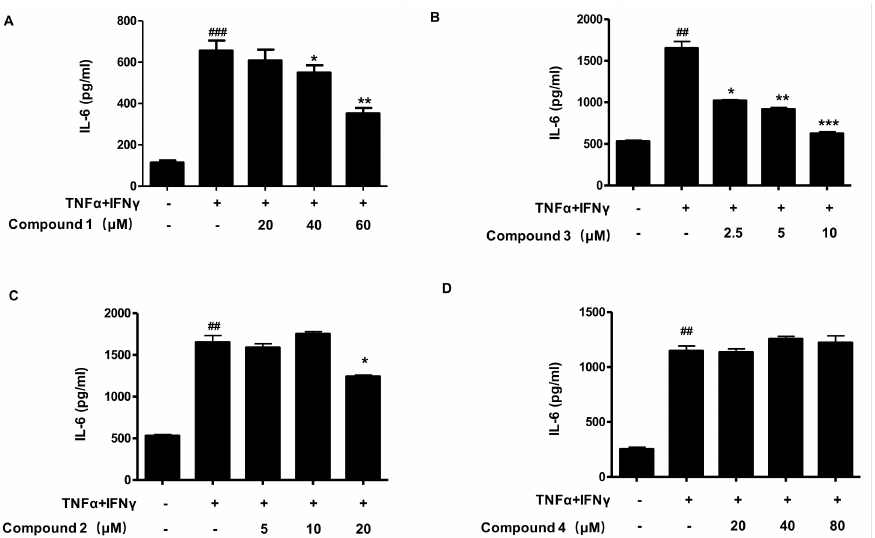
Figure 3. Effects of compounds 1 , 2 , 3 , and 4 on the secretion of IL-6 in TNF- α /IFN- γ -stimulated HaCaT cells ( A – D ). The secretion of IL-6 was measured by using the culture supernatant of TNF- α /IFN- γ -stimulated HaCaT cells. The cells were pretreated with the indicated concentrations of compound 1 , 2 , 3 , and 4 for 3 h (+) or not (-), and then stimulated with TNF- α /IFN- γ (+) for 24 h. Data are represented as the mean ± SD of three independent experiments. ## p < 0.01, ### p < 0.001 vs. control. * p < 0.05, ** p < 0.01, *** p < 0.001 vs. TNF- α /IFN- γ -treated